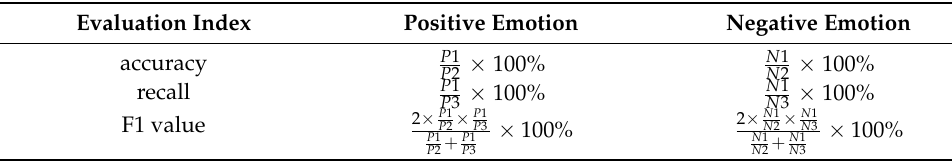
Table 6. Calculation Formula of Experimental